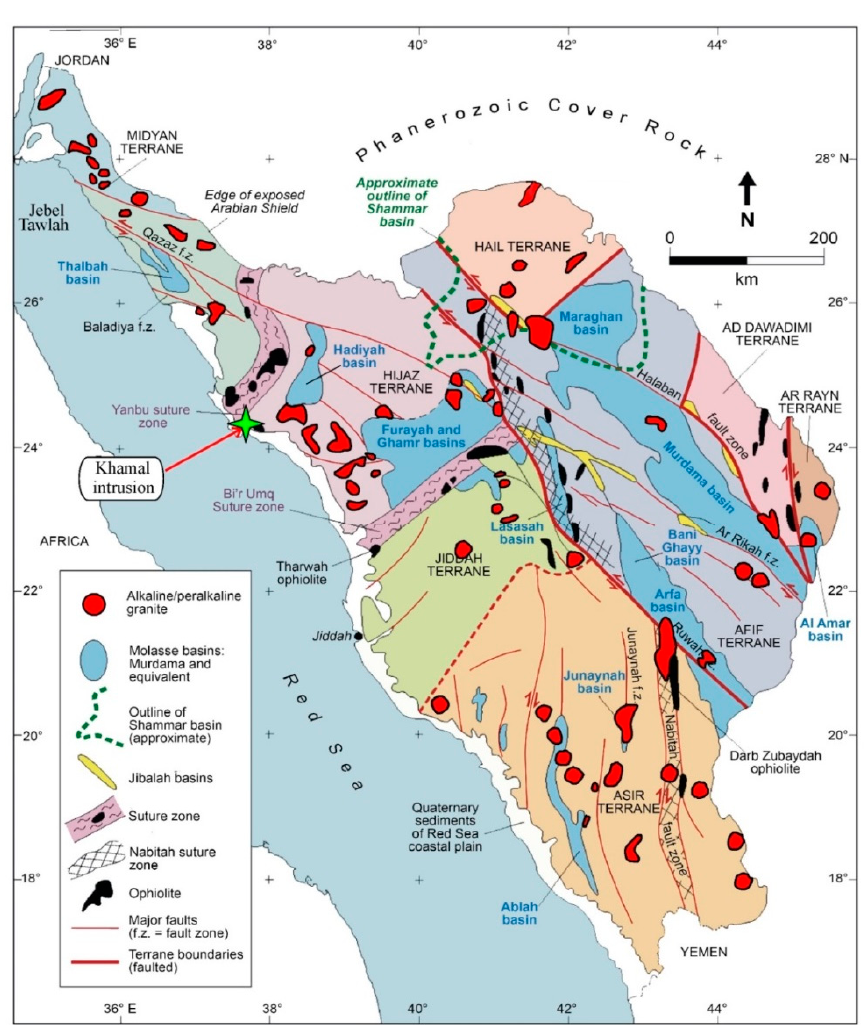
Figure 1. Simplified geologic map of the Arabian Shield in Saudi Arabia (modified after [18]). The location of the Khamal intrusion is indicated by a green asterisk.